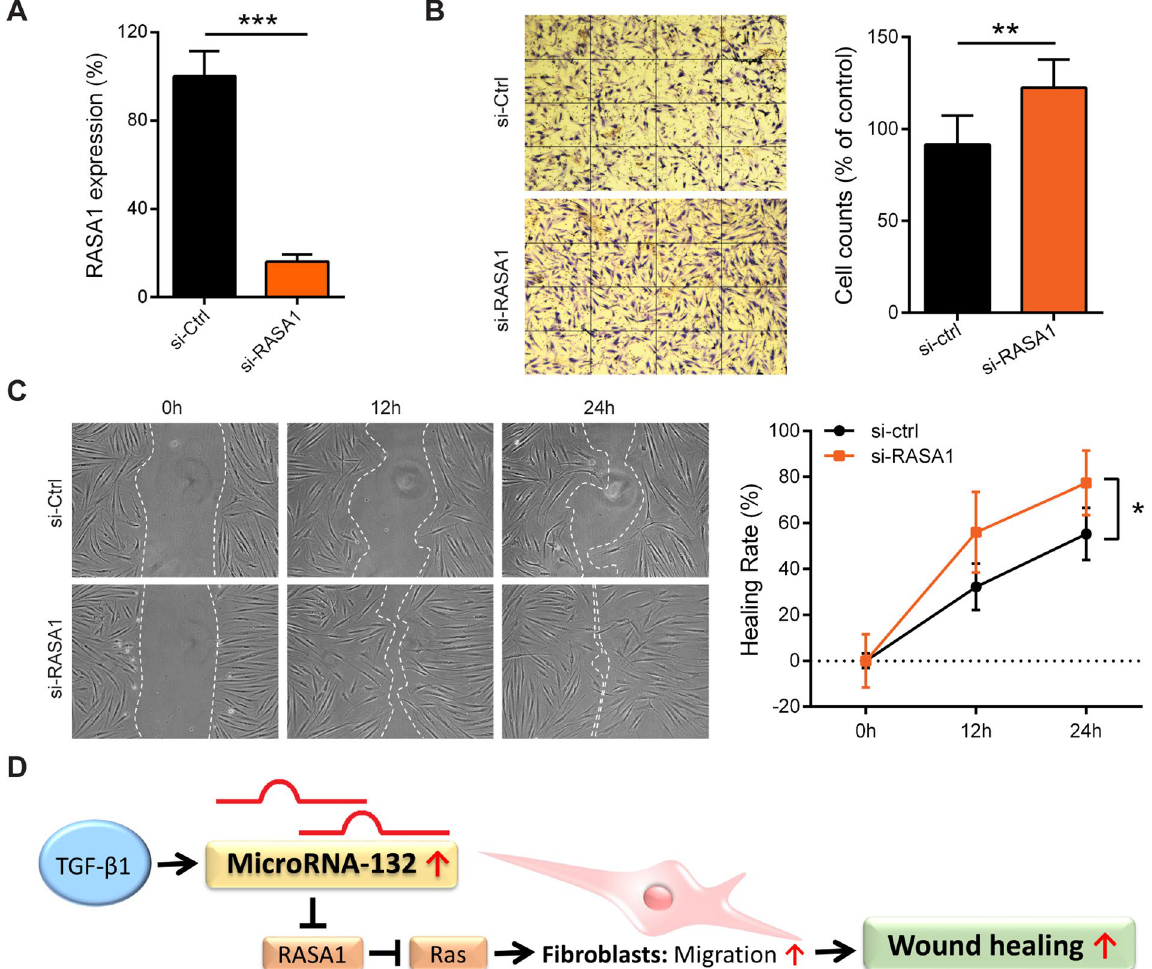
Figure 5. MiR-132 promotes migration by regulating RASA1. ( A ) RASA1 knockdown efficiency was analysed by qRT-PCR in HDFs transfected with 20 nM RASA1 specific siRNAs or control siRNAs (n = 3). ( B ) Transwell migration assay was performed in HDFs with silenced RASA1 expression (n = 3). ** P < 0.01 and *** P < 0.001 by Student’s t test. ( C ) Scratch assay was performed in HDFs with silenced RASA1 expression. * P < 0.05 by Repeated Measures Two-way ANOVA. The data are presented as mean ± s.d. ( D ) Schematic summary of the role of miR-132 in dermal fibroblasts during skin wound